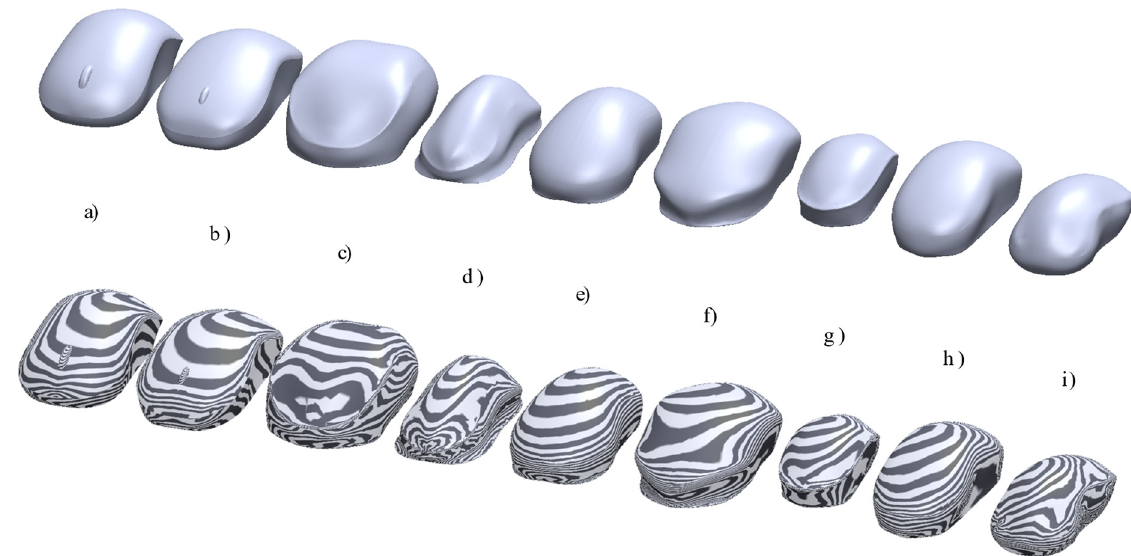
Figure 8. VR 3D modelling participants results: solid geometry models ( above ) and zebra stripes models ( below ). Case ( a ) reference mouse made in Solidworks; ( b ) mouse made by a Gravity Sketch expert user; ( c – i ) the participants’ results.